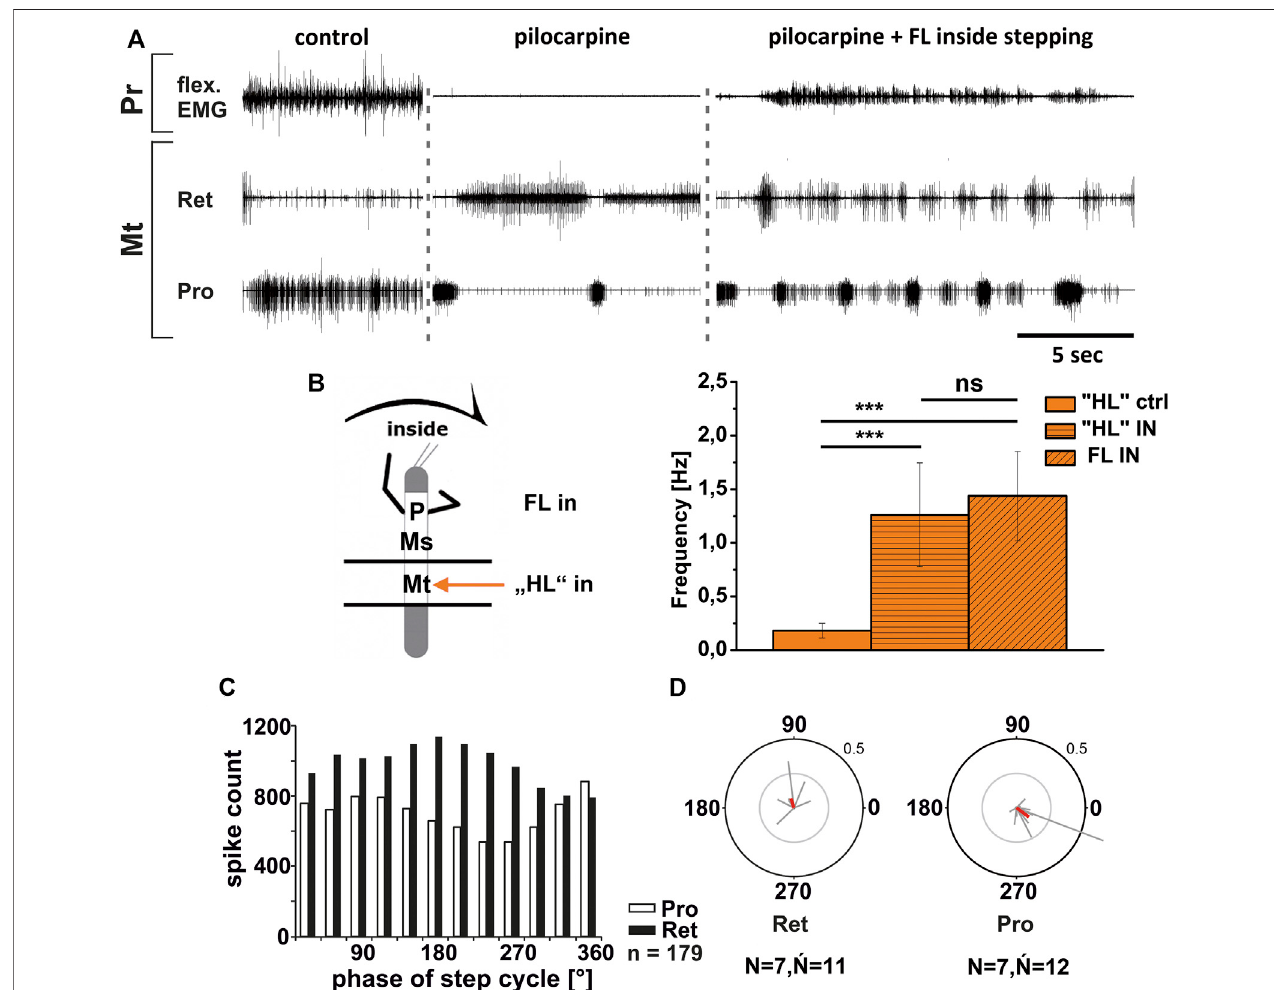
FIGURE6| Motoroutputof protractor (Pro)and retractor (Ret) coxae MNpoolsinthepilocarpineactivateddeafferentedmetathoracicganglionduringfrontleg(FL) insidestepping; (A) .FLFlexorEMG( “ fl ex ” ,top),togetherwithextracellularrecordingsoftheipsilateralmetathoracicretractor(nl5nerve,secondtrace)andprotractor(nl2 nerve,thirdtrace)nerveduringcontrolinsidesteps,inpilocarpinew/oFLsteps,andduringinsidesteppingunderpilocarpineapplication; (B) .Schematicofexperimental split-bathcon fi guration with comparison ofnl2pilocarpine controlBurst frequency( “ HL ” ctrl)withdeafferentHL-segment nl2 burstfrequency ( “ HL ” IN) duringinside steps of the front legs (FL IN) from 21 walking sequences in 11 experiments (signi fi cance level < 0.001) (C) . Phase histogram of retractor and protractor nerve activity under pilocarpine during inside stepping, with respect to the FL step cycle; (D) . Polar plots with the spike event maxima (grey vectors) and their means (red) for the metathoracic retractor (left) and protractor (right) during pilocarpine application with respect to the FL step cycle; N = number of animals; Ń = number of analyzed hemiganglia; n = number of analyzed steps. The sketch indicates a stick insect with front legs in a fl exed (inside) or stretched (outside) position, and the arrow above indicating the turning direction, the arrow on the side the recorded thoracic segment. The black bars symbolize the vaseline barrier.